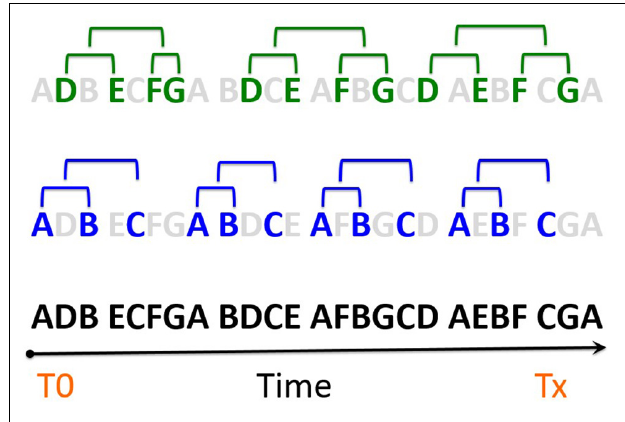
FIGURE 3 | Temporary events and regularities in a sequence of game (taken from Casarrubea et al., 2015). The elimination of superfluous events on a timeline is the procedure applied in Figures 5 , 6A,B . The bottom-line disorder hides a specific order based on events and time distances (top